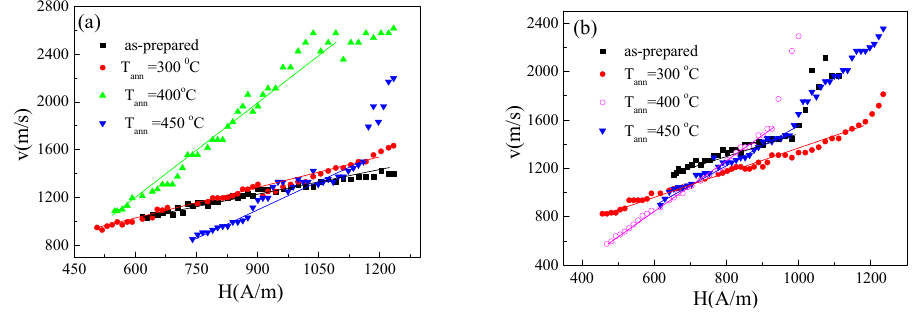
Figure 15. v (H) dependencies measured in as-prepared and annealed at different temperatures Fe 38.5 Co 38.5 B 18 Mo 4 Cu 1 microwires with ρ = 0.41 ( a ) and ρ = 0.6 ( b ). Reproduced from reference [70], Figure 8.